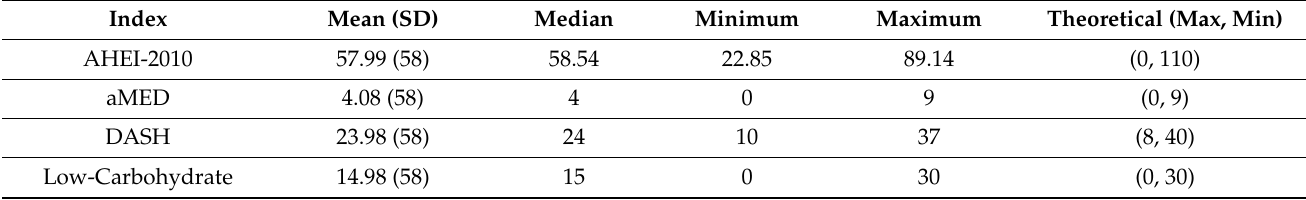
Table 3. Summary statistics for the diet quality index scores within this